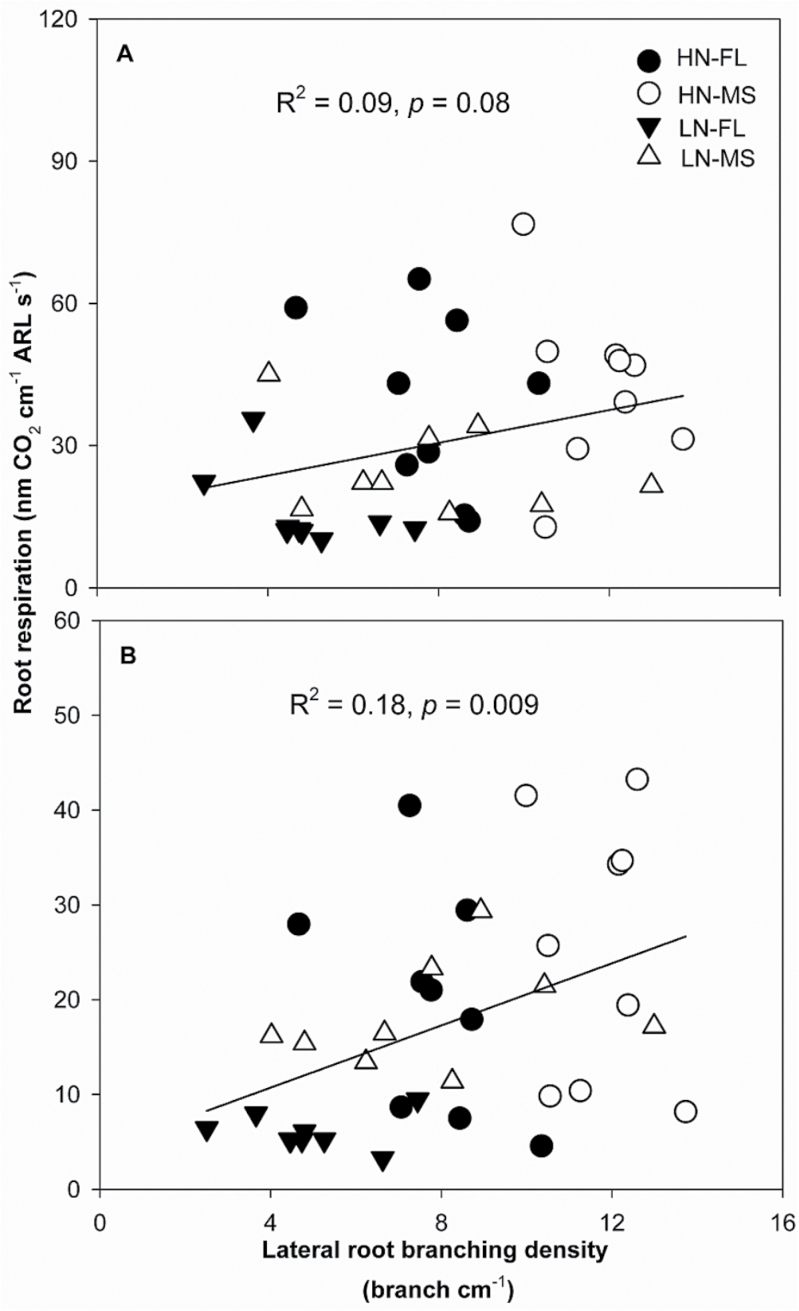
Correlation of axial root respiration per unit ARL (A), and lateral root respiration per unit ARL (B), with crown root lateral root-branching density as affected by high N (circles) and low N (triangles) at 42 days after planting for nine FL (filled symbols) and nine MS (open symbols) genotypes. Each point is the means of four replicates of each genotype.